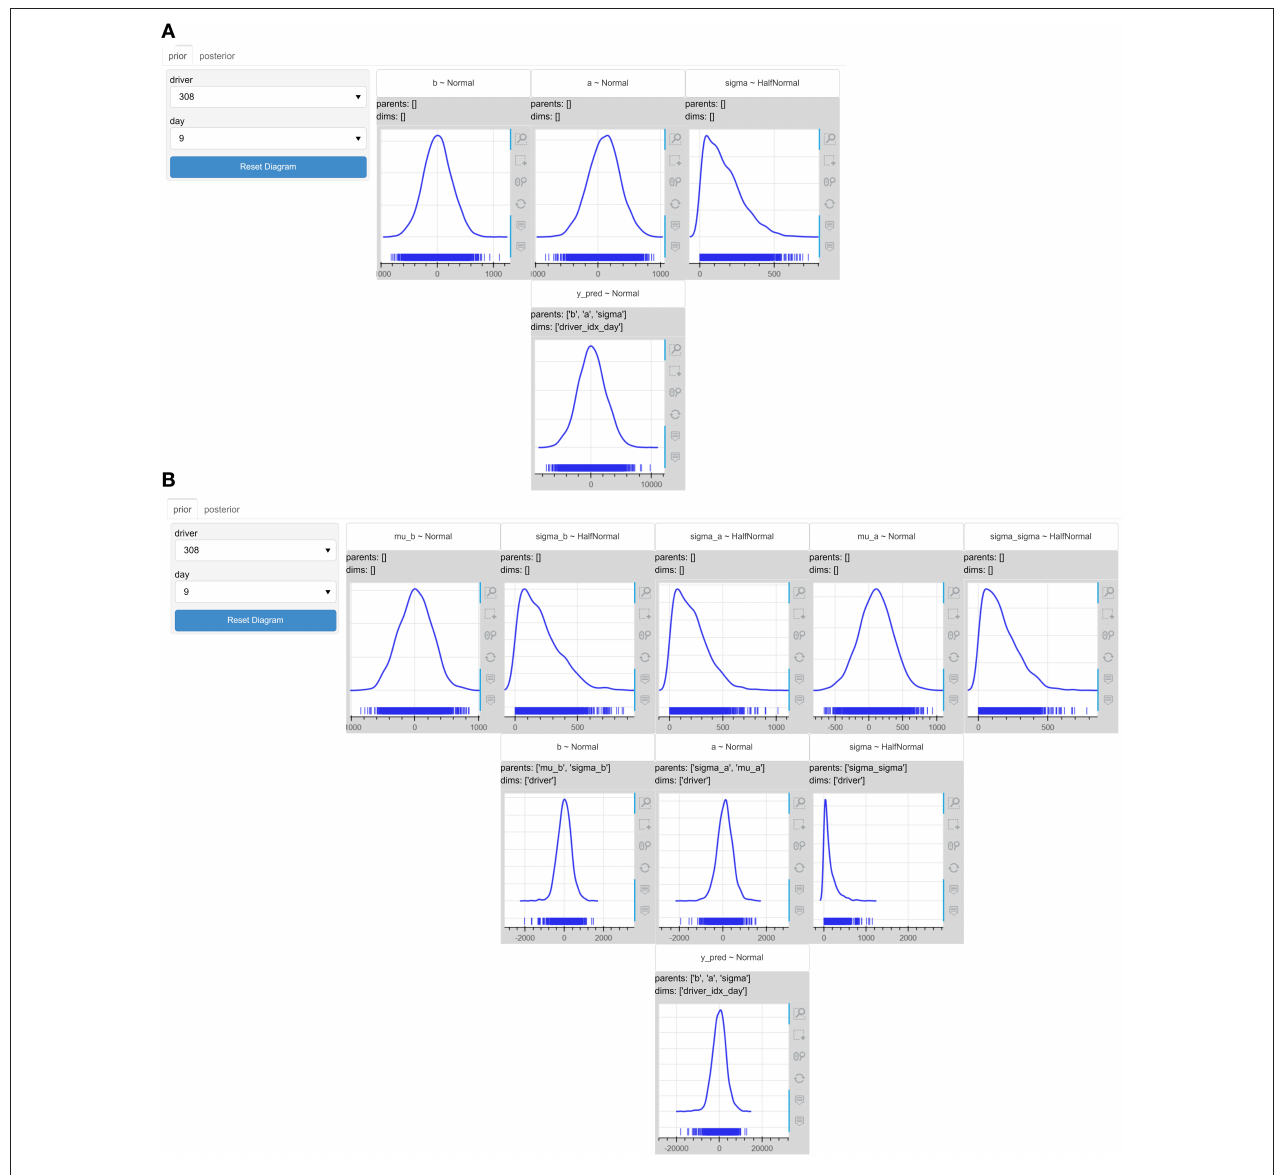
FIGURE 6 | The interactive probabilistic models explorer of the reaction times models. PyMC3 was used for the models’ specification and inference. (A) The prior graphical representation of the pooled model. (B) The prior graphical representation of the hierarchical model. The models predict negative slopes, and negative or very big (tens of seconds) values of reaction times a priori, which indicate that the priors might need to be